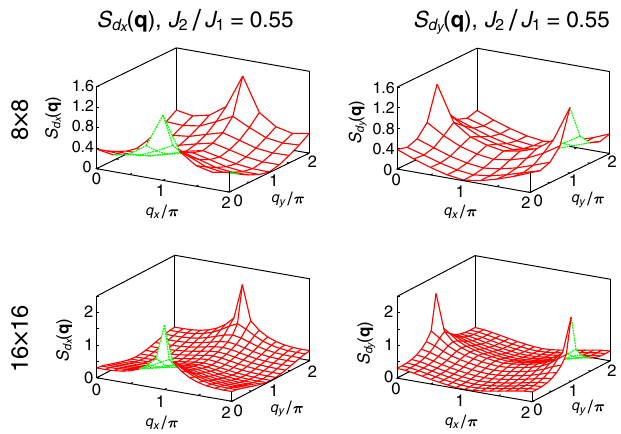
FIG. 15. Structure factor for dimer-dimer correlation S d and S d ð q Þ . y